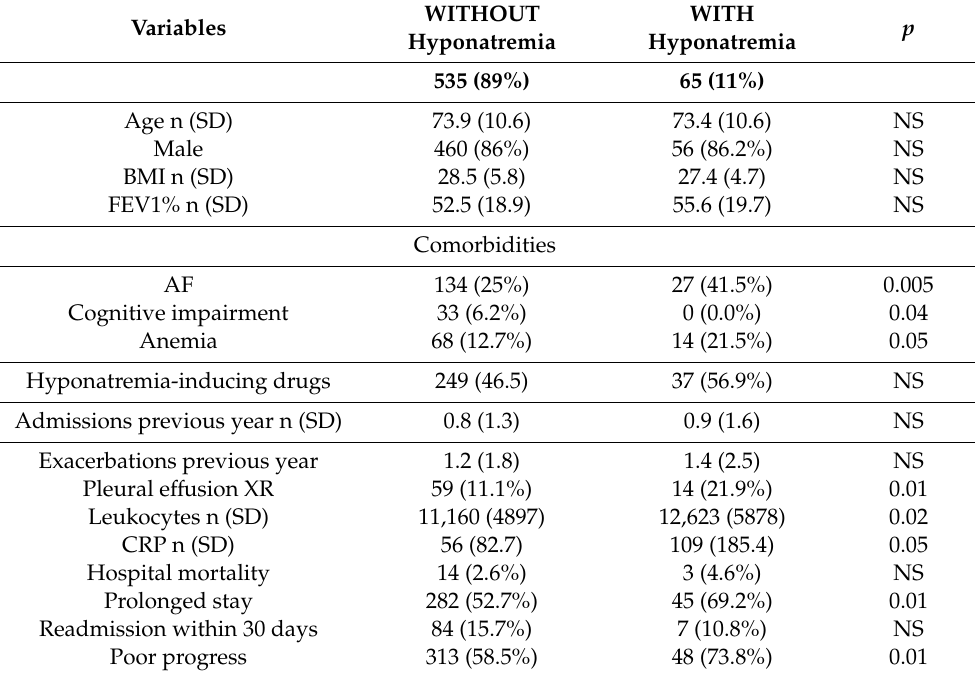
Table 4. General and clinical characteristics of patients with and without hyponatremia.